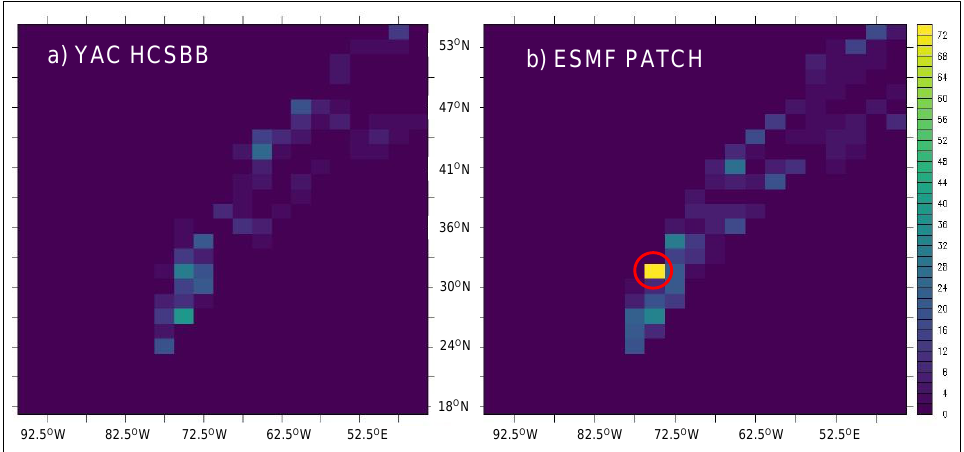
Figure 7. Misfit (%) for the gulfstream function in the gulf stream region for torc-bggd regridded with the second-order non-conservative algorithm for ( a ) YAC HCSBB and ( b ) ESMF PATCH. The red circle identifies the anomalous value near the coast for the ESMF patch algorithm discussed in the text.